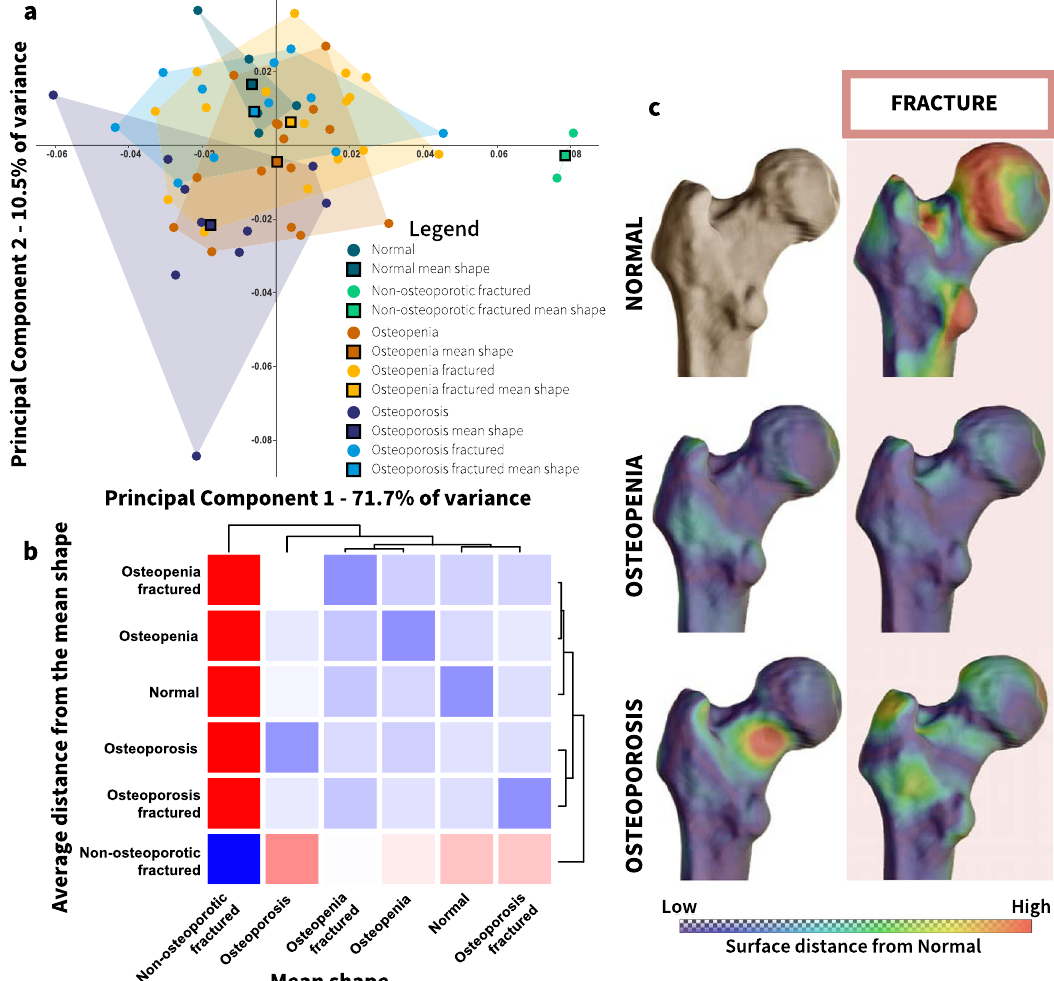
Fig. 2 Proximal femoral shape variance among living humans by osteoporosis and intracapsular hip fracture. a Between-group PCA of recent humans with and without an intracapsular hip fracture (ICHF), by osteoporosis diagnosis obtained from the DEXA scores ( N = 59). The non-osteoporotic ICHF group can be distinguished from the other groups along PC1. b Heatmap and dendrogram created from the average Procrustes distances of individuals belonging to the same group from the mean shape of each group. c The surface distance of the mean shape of each group from the mean shape of the control group (non-osteoporotic, not fractured) represented by colors (blue for the lowest differences and red for the largest